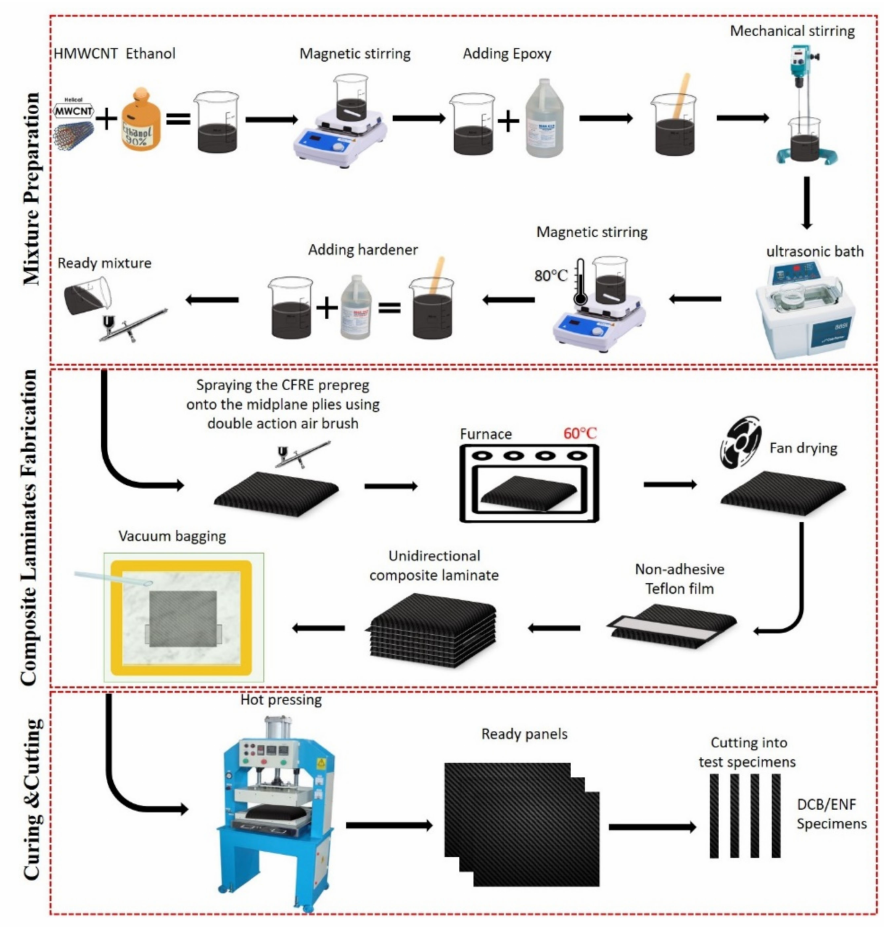
Figure 2. Schematic representation of the composite laminate preparation process flow.